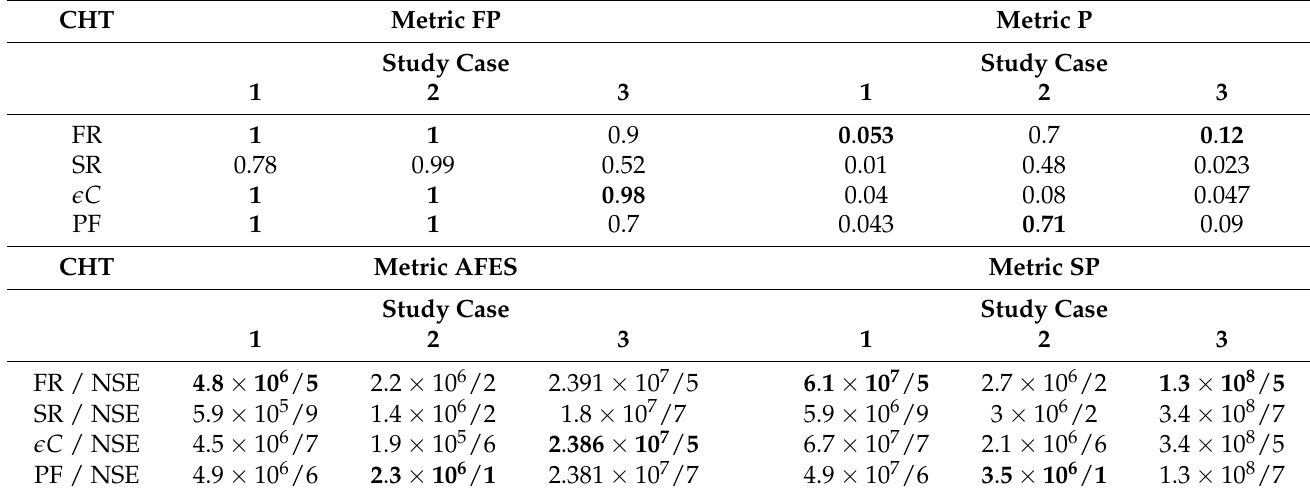
Table 9. Average metric values FP , P , AFES , and SP for each study case and for each constraint-handling technique included in the metaheuristic algorithms.